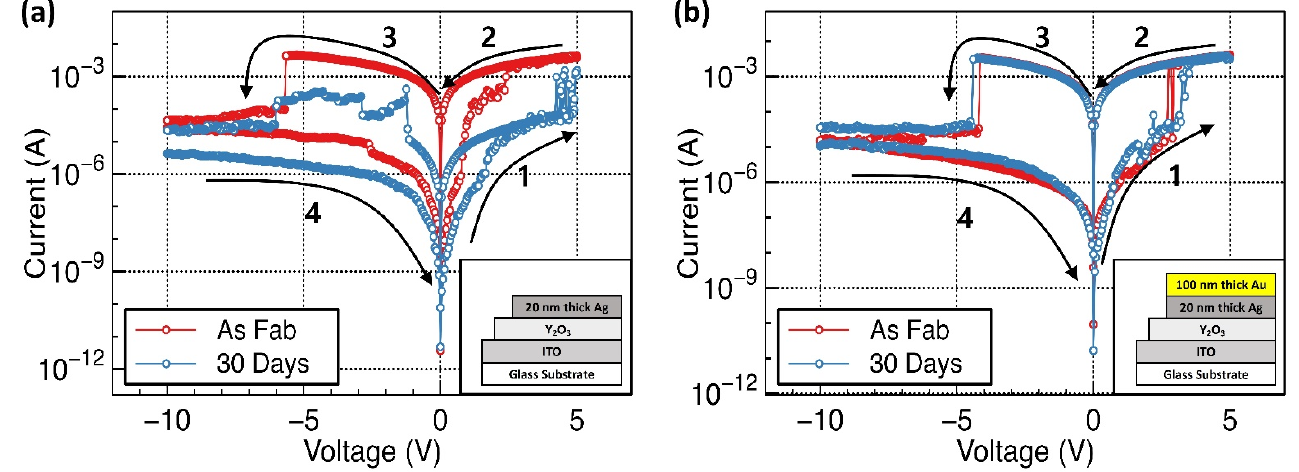
Figure 4. The representative I–V curves of pristine and 30-day stored Y 2 O 3 RRAM devices: ( a ) with Ag top electrodes and ( b ) Au-passivated Ag top electrodes, respectively. The insets show the schematic images of fabricated RRAM devices.